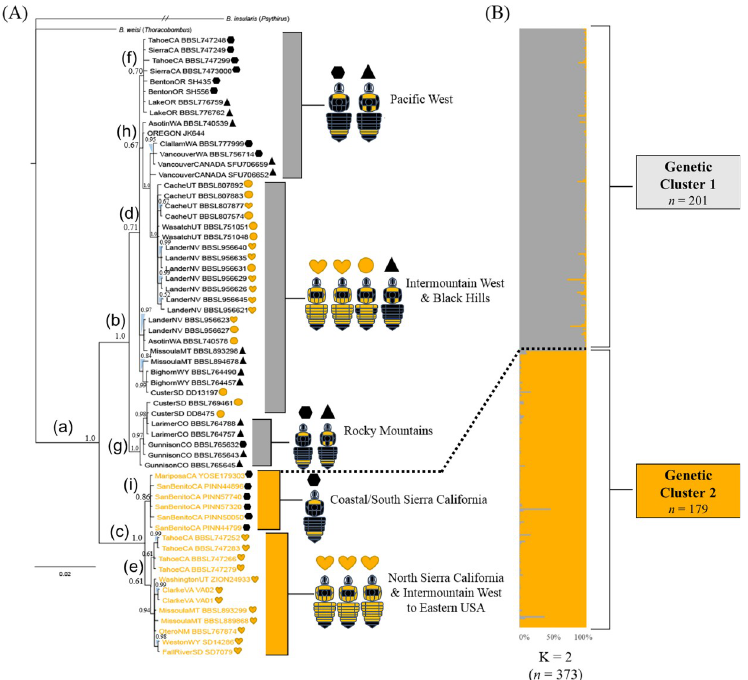
Fig 2. Phylogeny and microsatellite genotype assignment of B . fervidus and B . californicus . (A) Bayesian phylogeny of B . fervidus SC inferred using the fragments of three mitochondrial genes: cytochrome c oxidase I + 12s rRNA+ 16s rRNA. Values preceding each node correspond to Bayesian posterior probabilities. The scale bar indicates branch lengths in expected substitutions per site. Specimen phenotype group is mapped out with a corresponding shape and color. Phenotype 1 = black hexagon, phenotype 2 = black triangle, phenotype 3 = orange circle, phenotype 4 = orange heart. Outgroups = B . weisi ( Thoracobombus ) and B . insularis ( Psythirus ), with the branch length of the latter species truncated. Bold lowercase letters refer to the clades associated with a node preceding each lineages’ geographic distribution. (B) Fractional genotype assignment (genetic cluster) based on a Bayesian analysis of 13 microsatellite loci implemented in Structure assuming K = 2. Each horizontal bar represents a single specimen’s microsatellite genotype, where each color represents a fractional assignment to one of two genetic clusters. Colors of each fractional genotype correspond to the text color of the specimens mapped on the Bayesian phylogeny (A). Dashed line associating the phylogeny to the fractional genotype assignments of the Structure plot link the pool of corresponding individuals that were sequenced and